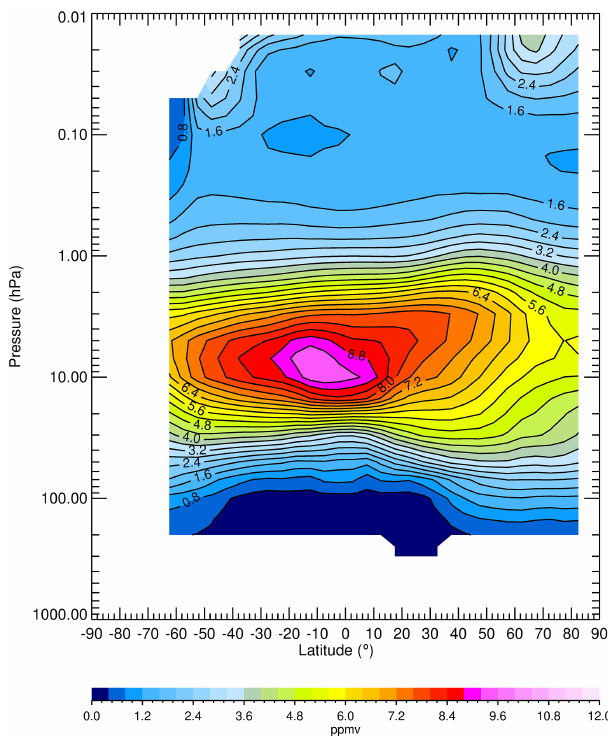
Figure 1. LIMS V6 Level 3 monthly zonal mean ozone for descend- ing mode only (or nighttime equatorward of ∼ 55 ◦ S) for January 1979. Contour interval (CI) is